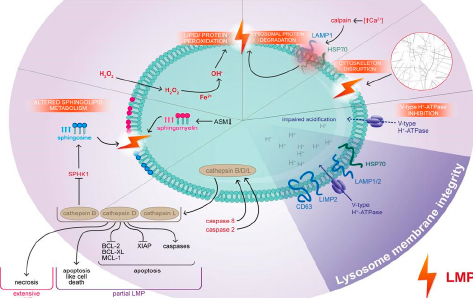
Figure 1. Triggers of lysosomal membrane permeabilization. Lysosome membrane integrity is protected by heat shock protein 70 (HSP70) as well as lysosomal-associated membrane protein 1/2 (LAMP1/2), lysosome integral membrane protein 2 (LIMP2) and CD63. Accordingly, degradation of LAMP1 and HSP70 leads to lysosome membrane permeabilization (LMP). LMP may be also induced by other stimuli, including ROS (H2O2), proteases such as caspases and calpains, cytoskeleton disruption and changes in sphingolipids composition in lysososmal membrane, e.g., increase in sphingomyelin and sphingosine. Inhibition of V-type H + ATPase and therefore impaired acidification of the lysosome is also contributing to its destabilization. As a result of these events, the breakdown of lysosomal membrane provokes cathepsins release and subsequently lead to cell death. Detailed characteristic of LMP promoting mechanisms are described in paragraph 2. The LMP-inducing mechanisms are displayed in